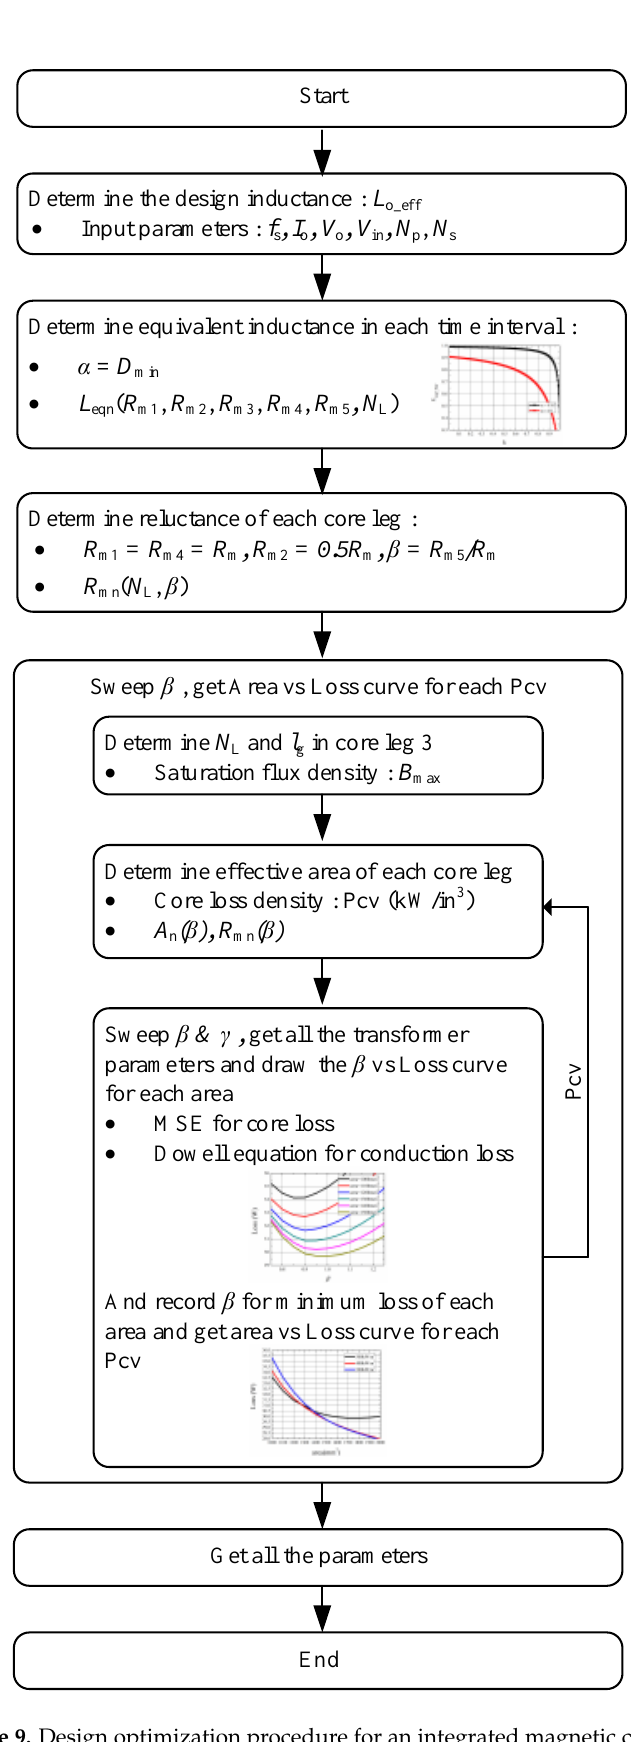
Figure 9. Design optimization procedure for an integrated magnetic component.